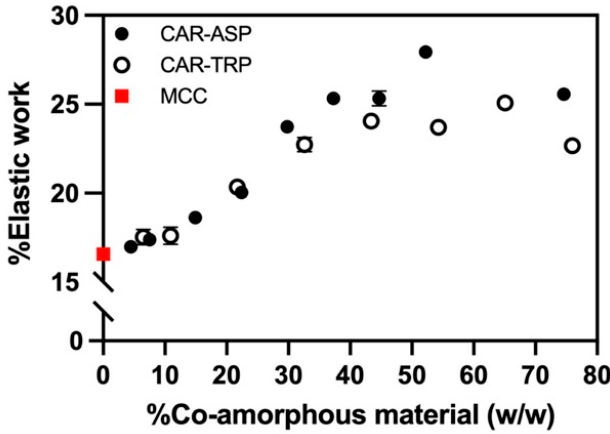
Figure 4. Elastic work (%) of CAR:ASP (%, w / w ) (closed circle), CAR:TRP (%, w / w ) (open circle), and MCC (red square) tablets calculated. n = 6, average ± st. dev.